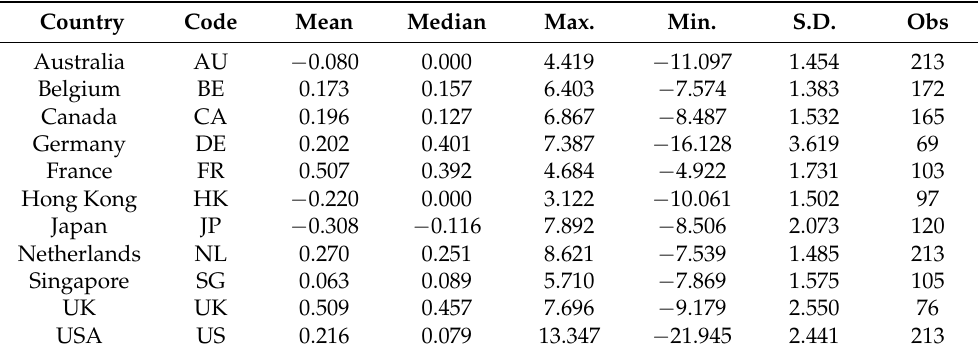
Table 1. Summary statistics. The table presents summary statistics of the 11 leading international REIT